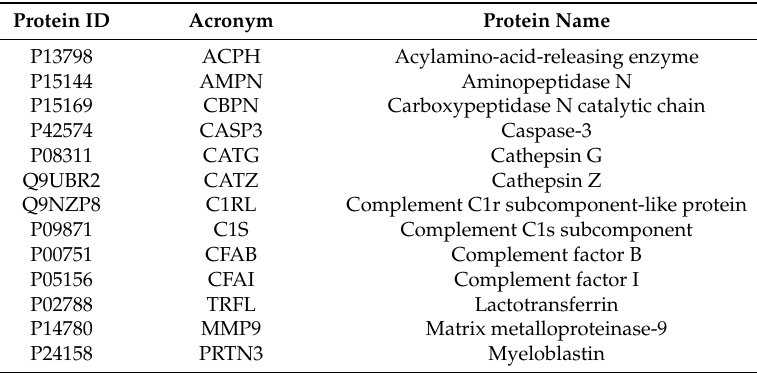
Table 6. Proteinases and peptidases in wound